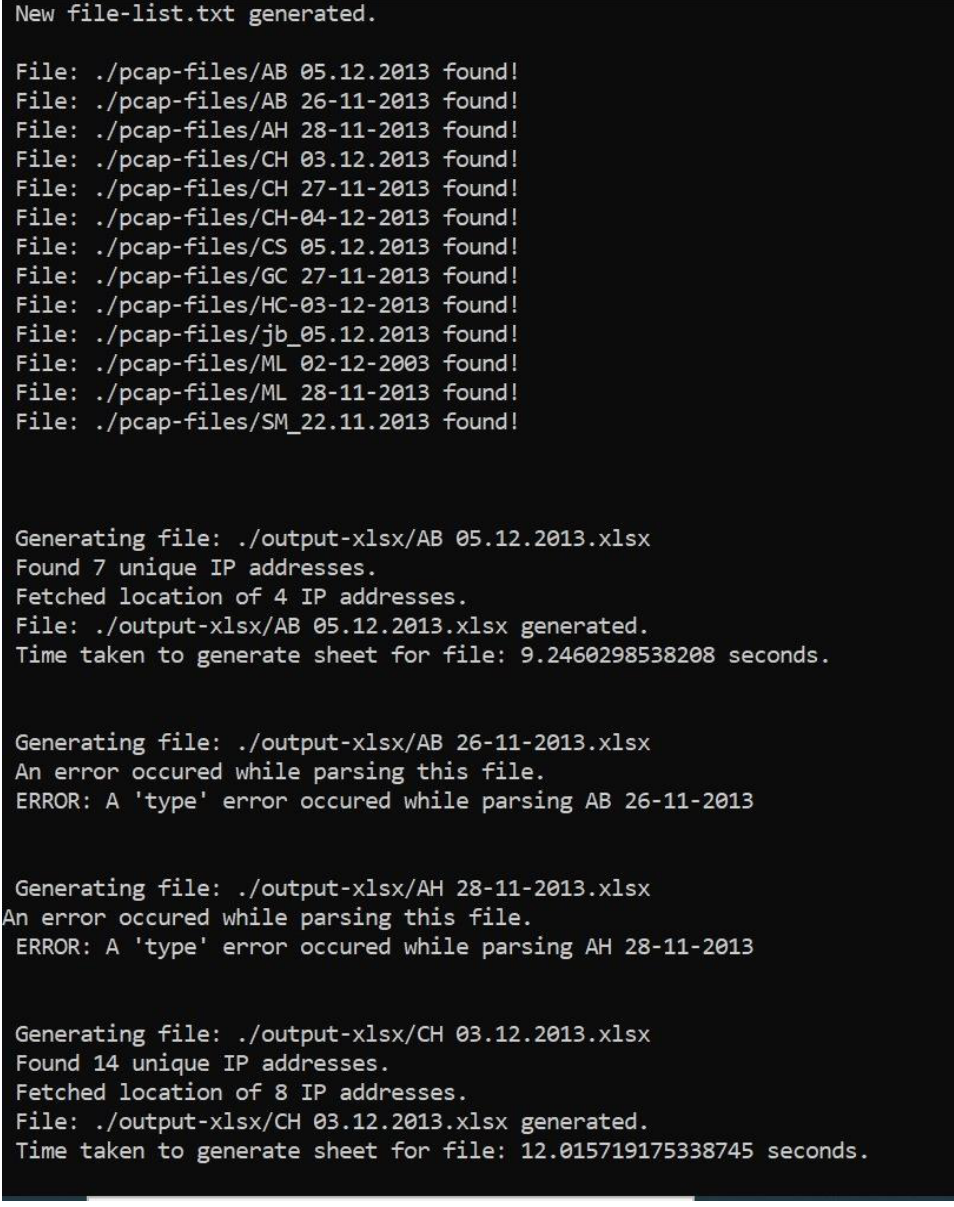
Figure 4. Workflow for raw PCAP file traffic-based feature extraction and experimental results for Unique I.P. addresses with Time complexity.